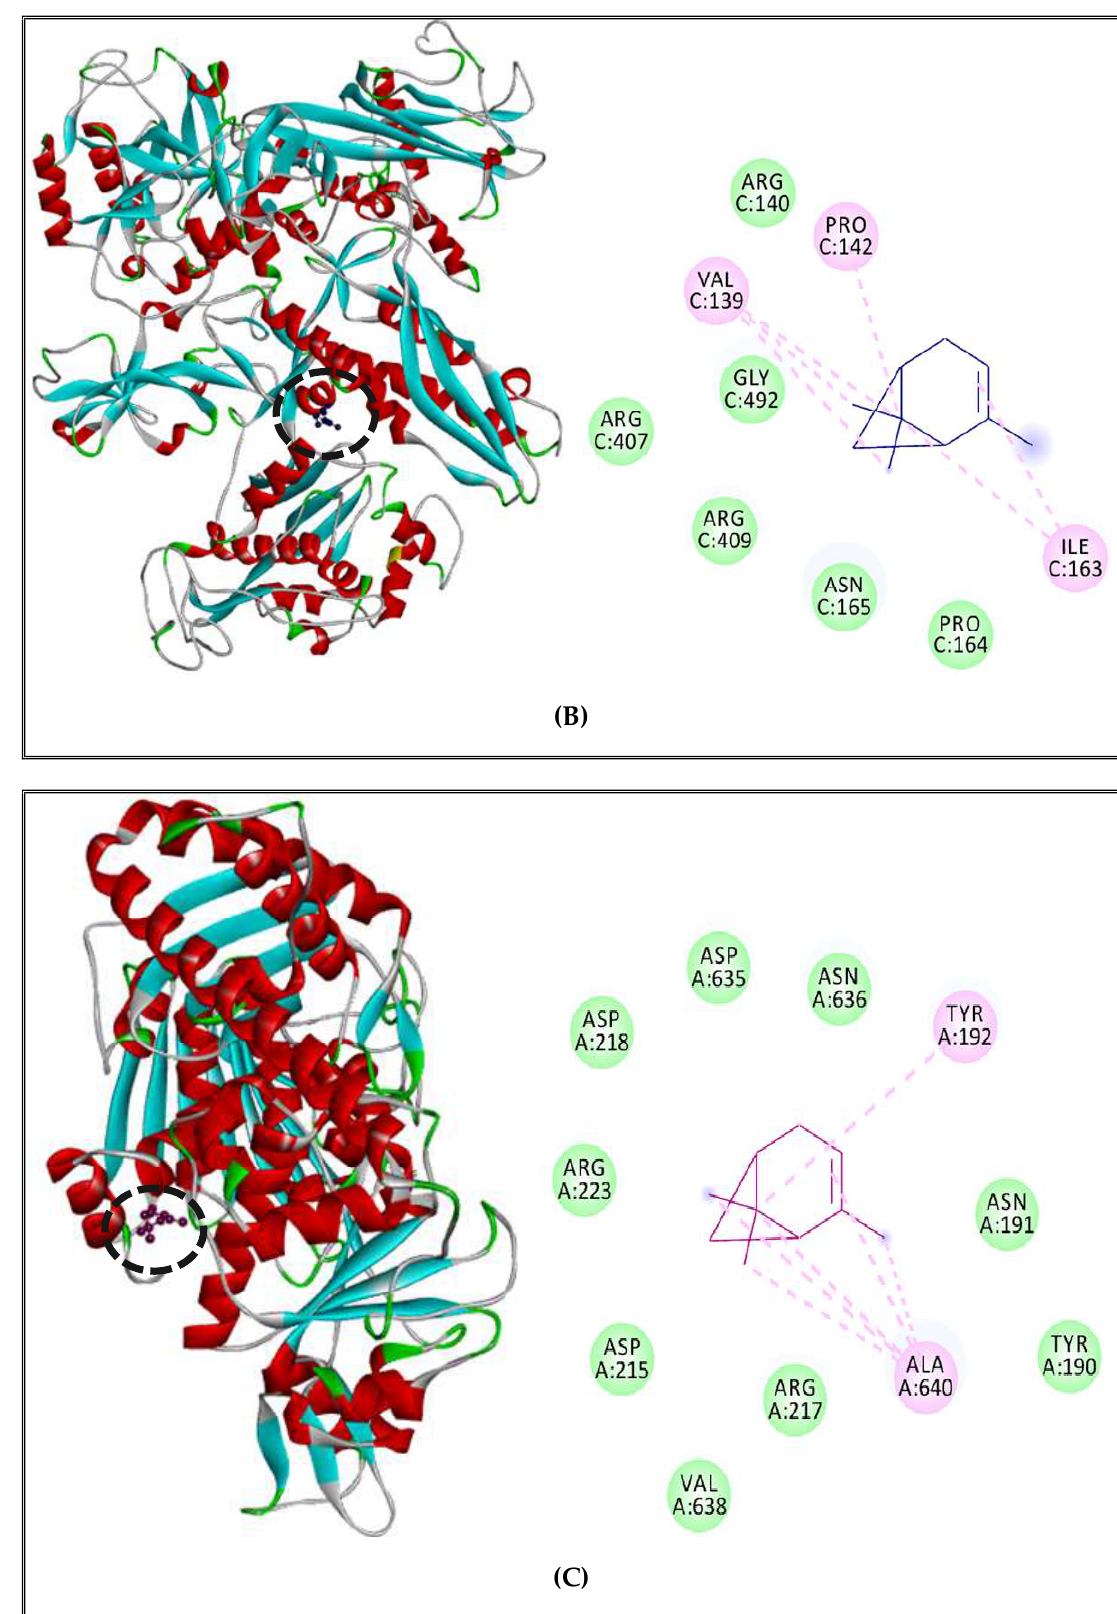
Figure 4. α-Pinene complexed with DNA polymerase enzyme ( A ), RNA polymerase ( B ), topoiso- merase II ( C ) of S. aureus.